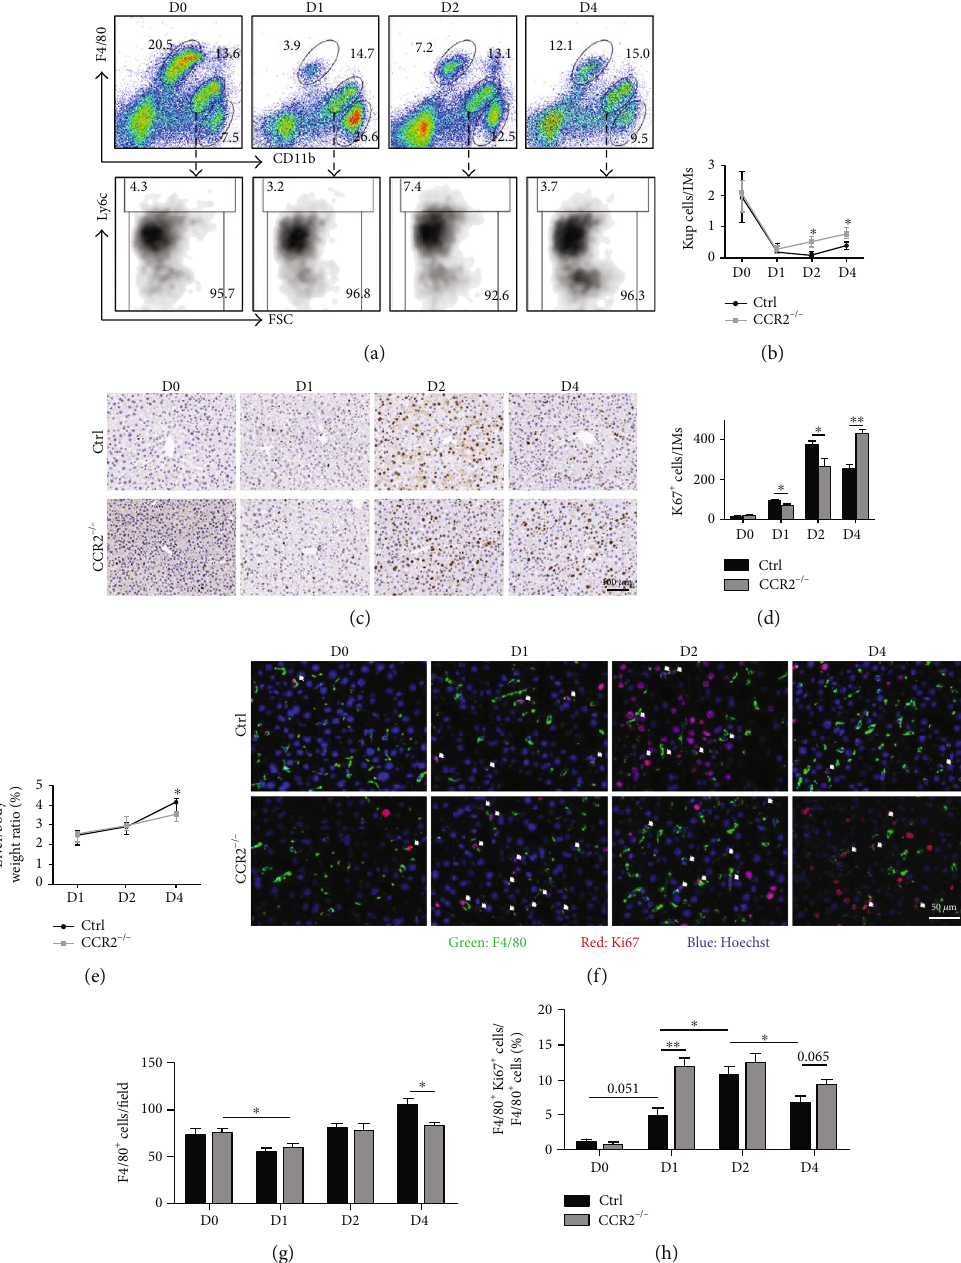
Figure 4: Liver regeneration was delayed when in fi ltration of circulating monocyte was blocked in CCR2 − / − mice after PHx. (a) C57BL/6 mice and CCR2-KO mice were sacri fi ced D1, 2, or 4 after 2/3 PHx or sacri fi ced immediately after sham operation. The subpopulation of HNPCs in control and CCR2-KO mice was analyzed by FACS with anti-F4/80, anti-CD11b, and anti-ly6C antibodies at the indicated times after PHx. (b) The ratios of KCs/IMs in (a) were determined and quantitatively compared. (c) Liver sections were stained with anti-Ki67 IHC. (d) The number of Ki67 + cells in (c) was counted and quantitatively compared. (e) Liver-body weight ratios of control and CCR2-KO mice were quantitatively compared at the indicated times. (f) Liver sections stained with anti-F4/80 and anti-Ki67 immuno fl uorescence and counter-stained with Hoechst. The arrow indicated the double-positive cells. (g) The number of F4/80 + cells in (f) was counted and quantitatively compared. (h) The percentage of double-positive cells in macrophages was determined and quantitatively compared in (f). Bars = means ± SD , n = 4 . ∗ P < 0 : 05 , ∗∗ P < 0 : 01